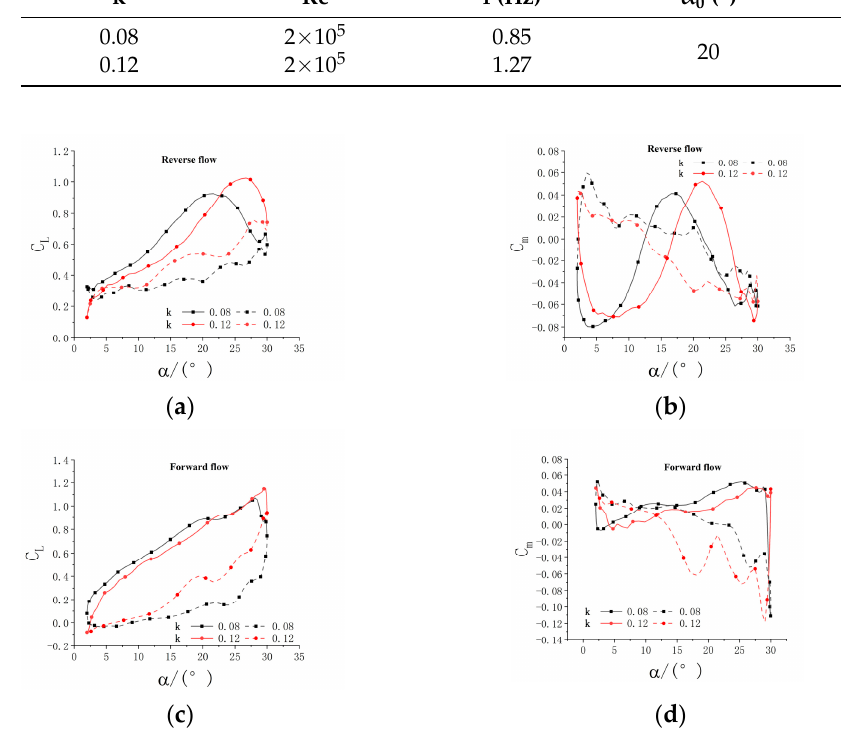
Figure 18. Effect of the reduced frequencies. ( a ) C L , ( b ) C m , ( c ) C L , ( d ) C m .